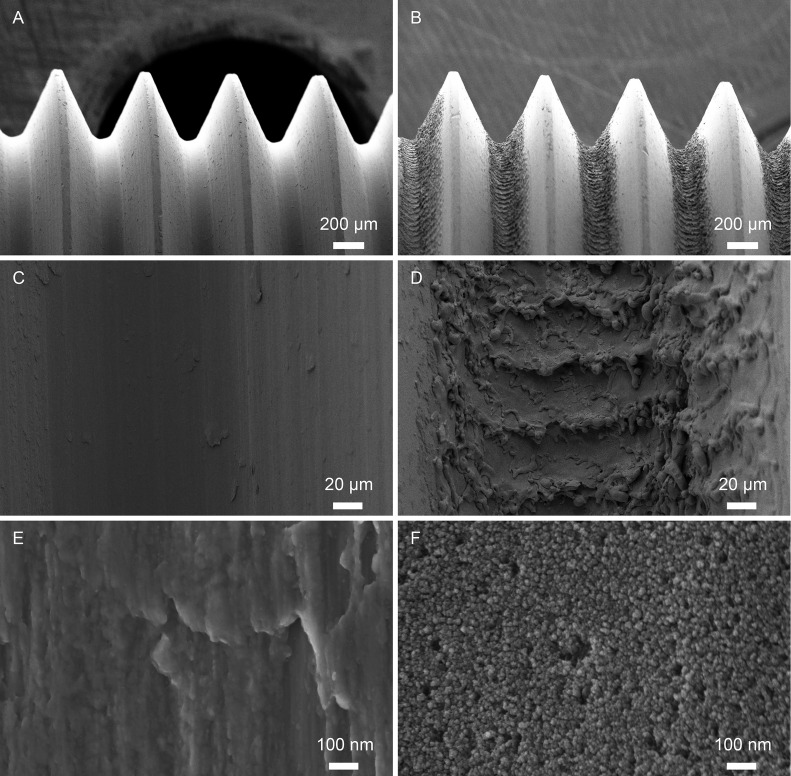
SEM images of the implant surface.Low-magnification images of the (A) machined and the (B) laser-modified implants. Surface microtopography of the (C) machined and the (D) laser-modified implants. High-magnification images show (E) ridges and grooves as remnants of the machining process for the machined implants and (F) a distinct nanotexture superimposed on the surface microtopography of the laser-modified implants.